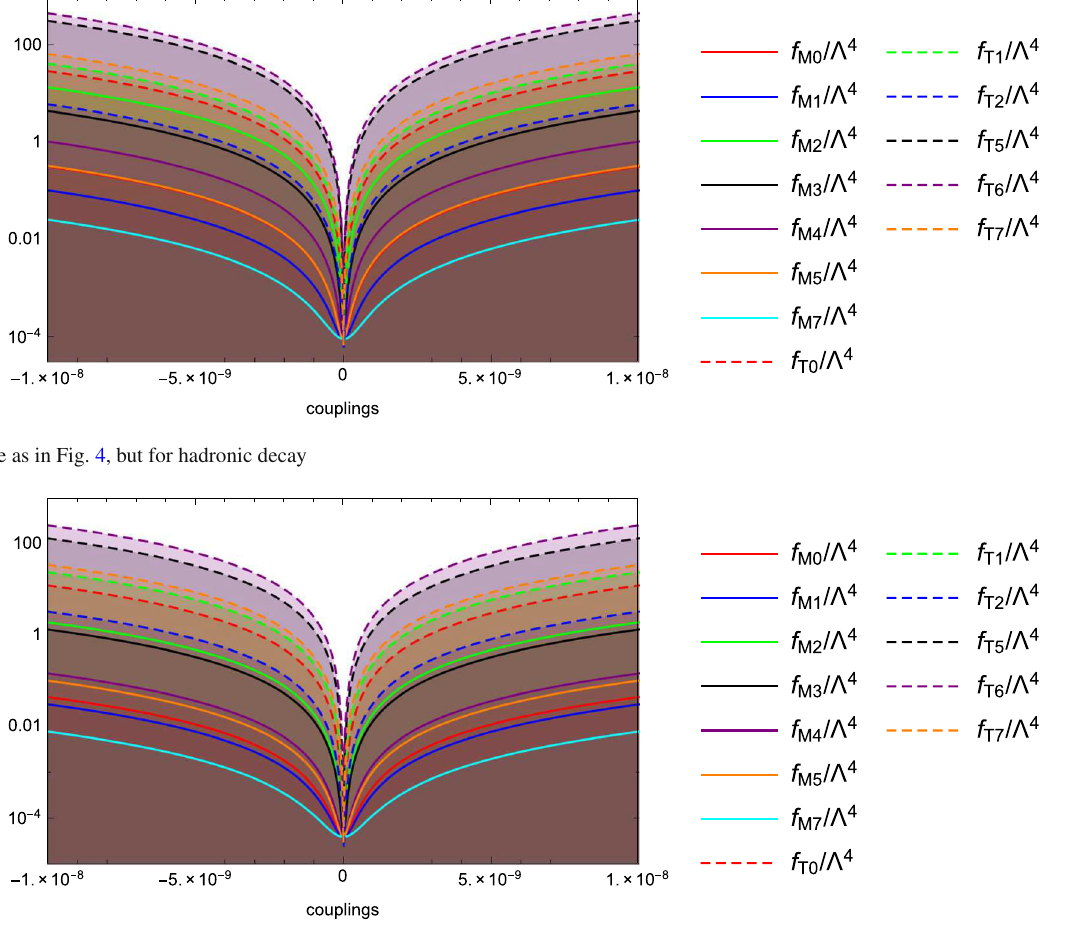
Fig. 7 For leptonic channel, the total cross-sections of the process e − p → e − γ ∗ p → pW − γν e as a function of the anomalous couplings at the √ s = 3 . 46 TeV FCC-he with